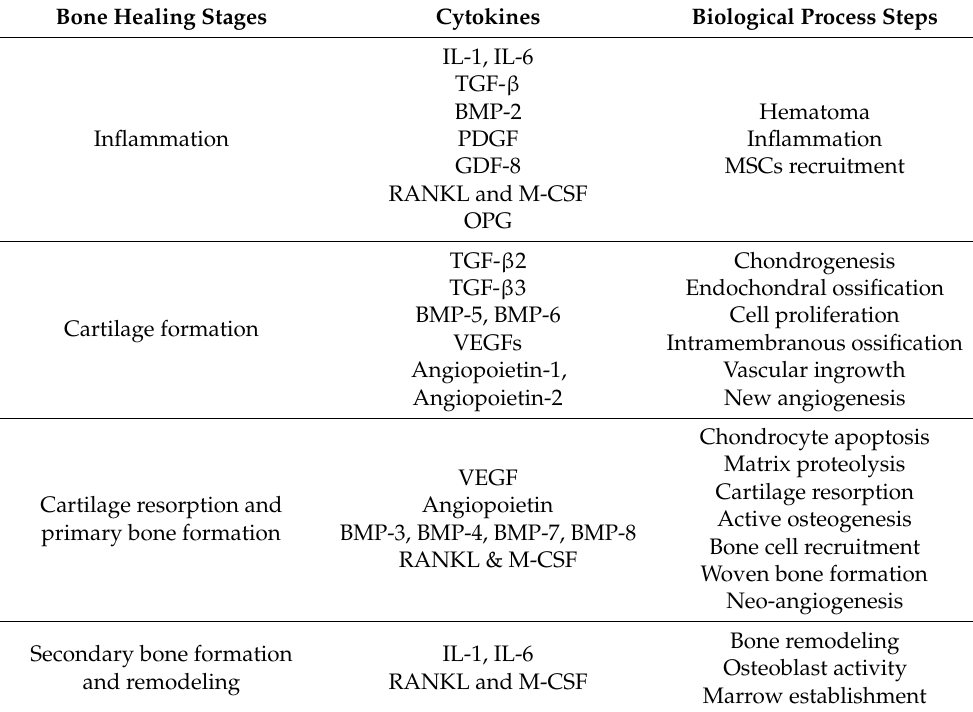
Table 3. Bone-healing stages involving different biological processes and cytokines